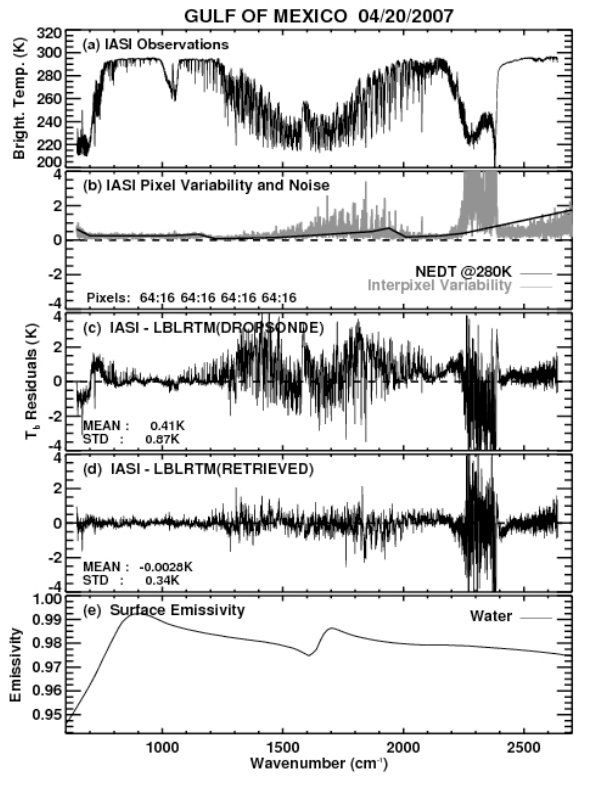
Fig. 3. (a) IASI measured spectrum in brightness temperature for the ocean case. (b) Spectra showing the variation within the four pixels averaged to obtain the measurement vector. (c) IASI/LBLRTM comparison for full IASI wavenumber range with initial guess input. (d) Comparison after retrievals of atmospheric temperature, H 2 O, O 3 , CH 4 , CO, OCS and HNO 3 . (e) Sea surface emissivity.